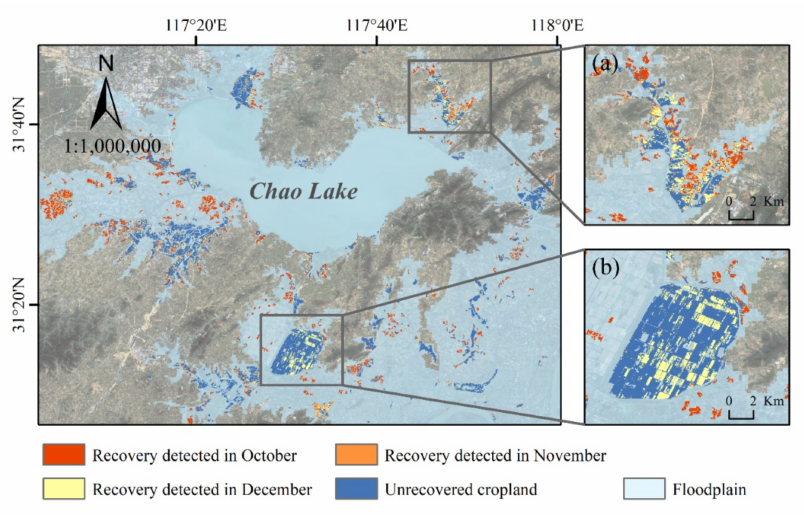
Figure 9. Spatial and temporal patterns of agricultural recovery around the Chao Lake. The zoom- in maps show recovery conditions of the flooded cropland mainly due to ( a ) rising waters and ( b ) flood